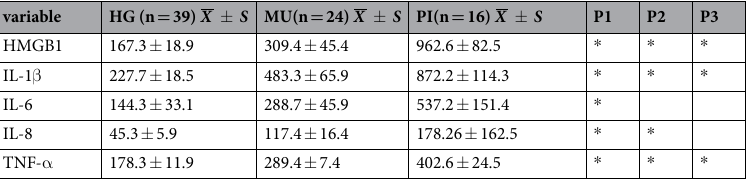
Table 3. Comparison of the concentration of HMGB1, IL-1 β , IL-6, IL-8 and TNF- α in PICF (pg/ml) in different stages of peri-implant disease. values are presented as the mean ± standard deviation; P P1 : HG vs. MU, P2 : HG vs. PI, P3: MU vs. PI; * p -value ≤ 0.05. The means in the different groups were compared using one- way ANOVA and LSD multiple comparison.